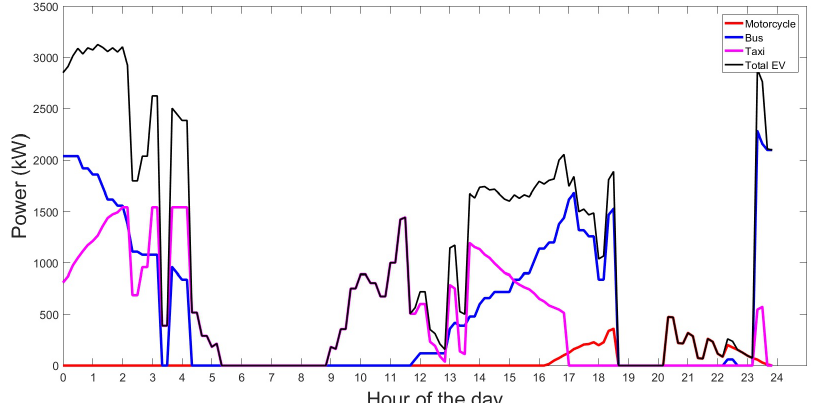
Figure 4. Charging pattern from each type of EV, with smart charging, for Scenario